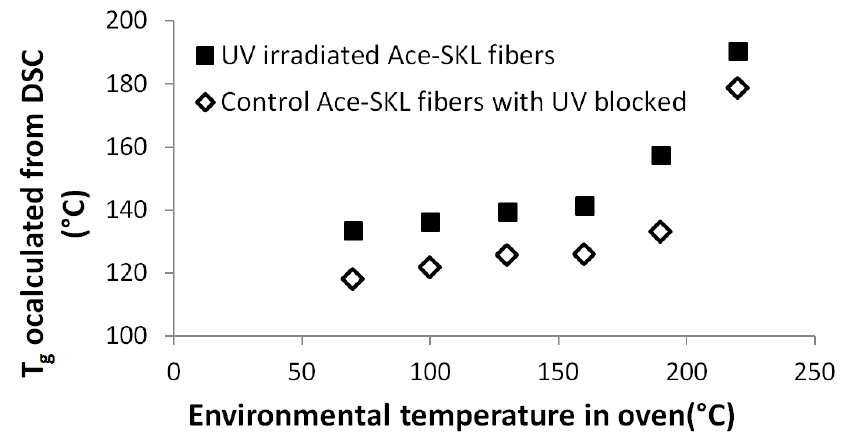
Figure 5. T shift of UV treated and control fibers as a function of thermal stabilization g temperature.